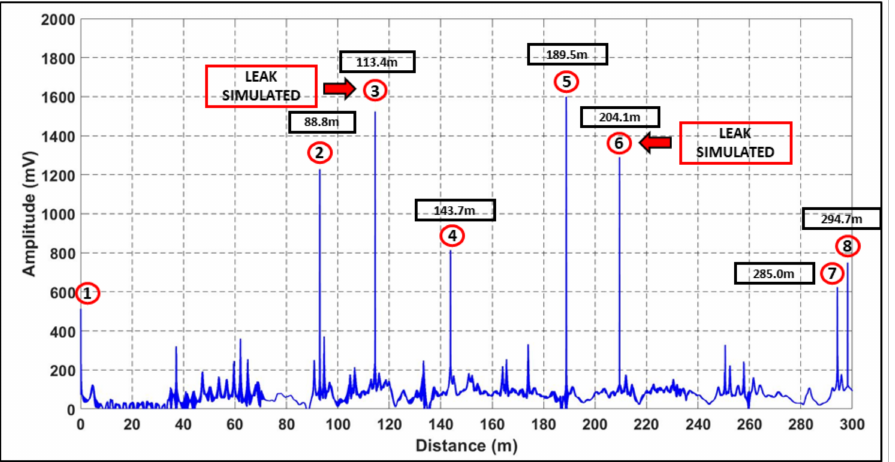
Figure 23. Hilbert Transform (HT) analysis IMF series 6 for 5 mm leak induced on fire hydrant 2 and